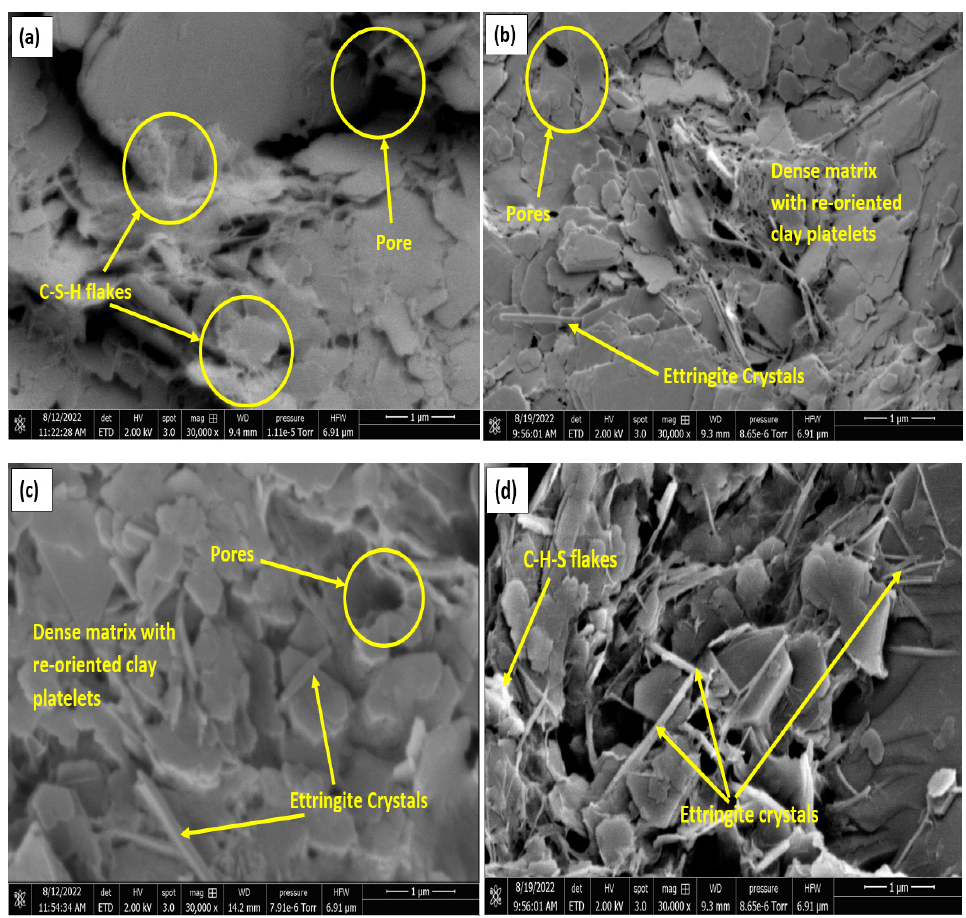
Figure 12. SEM Results of 7-days cured OPC and LGGBS treated gypseous samples. ( a ) OPC-treated 0%Gypsum. ( b ) LGGBS treated 0%Gypsum. ( c ) OPC-treated 35%Gypsum. ( d ) LGGBS-treated 35%Gypsum.